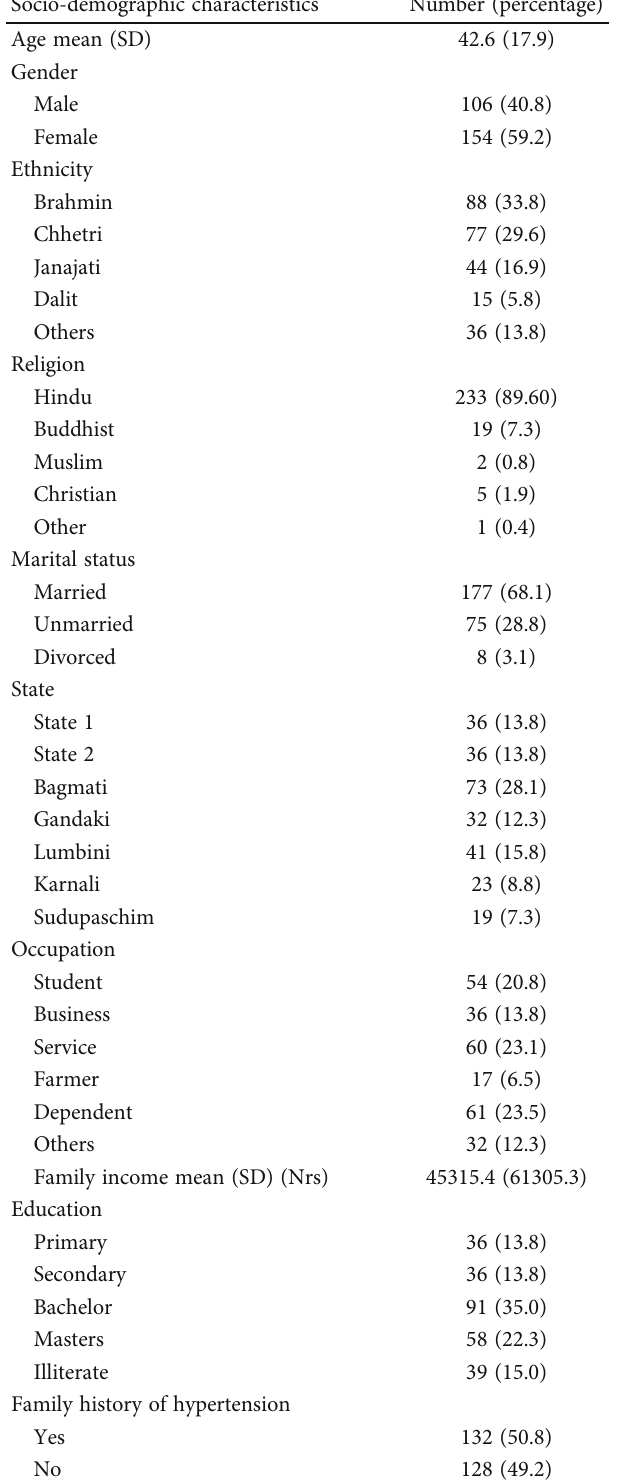
Table 1: Sociodemographic characteristics of the study participants ( n = 260 ).